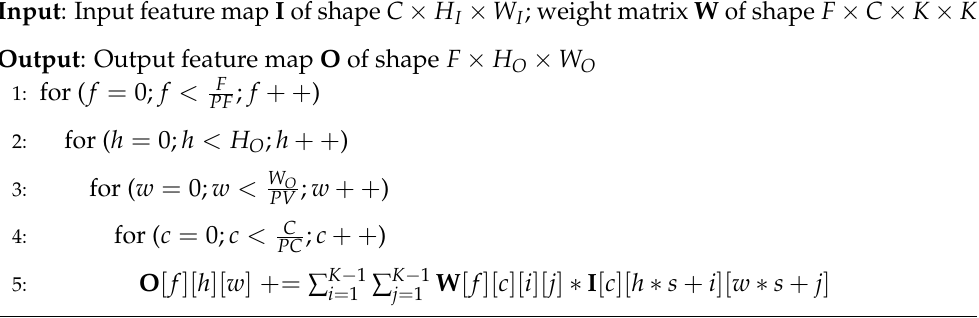
Algorithm 2 Channel-major computational